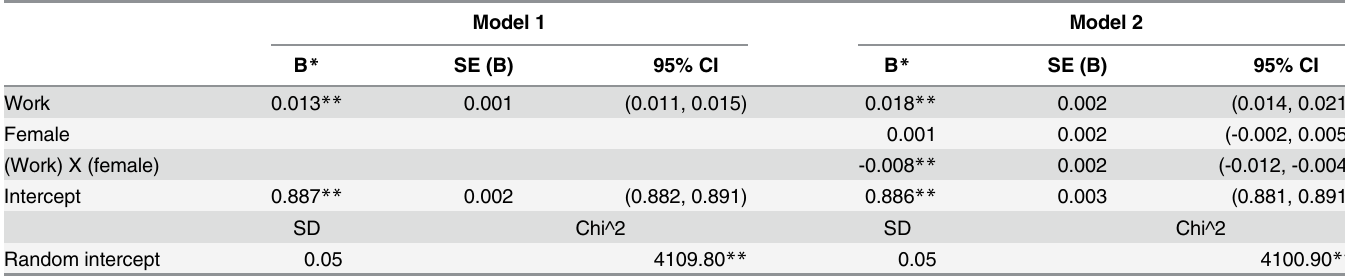
Table 2. Random effect panel regression model of